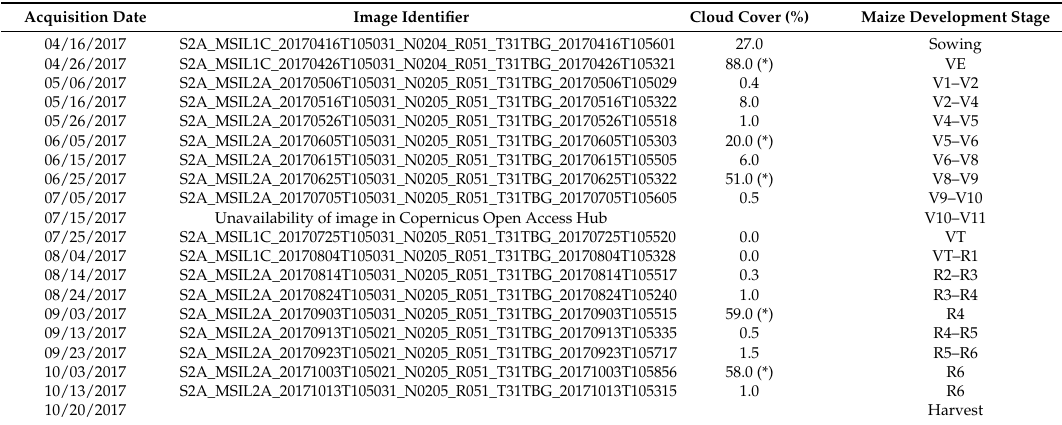
Table 1. Sentinel-2A images considered in the present study and maize stage of development according to Ritchie et al.